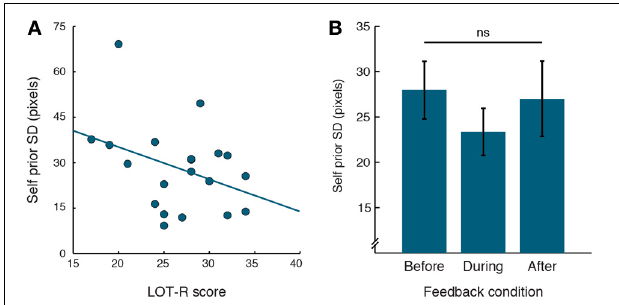
FIGURE 3 | Relation between Self priors and cognitive positive illusions. (A) Correlation of Self priors with LOT-R, with linear regression line. (B) Self prior SDs plotted for the different feedback conditions. Prior SDs did not differ across feedback conditions. Error bars indicate standard error of the